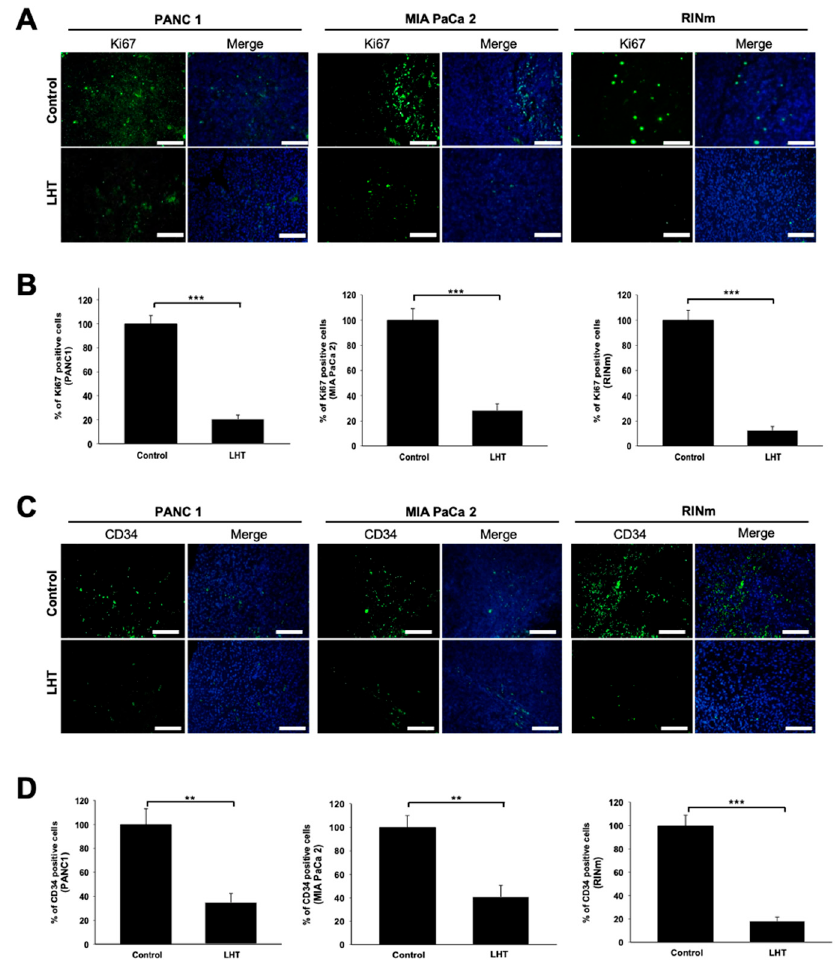
Figure 8. Inhibition of cell proliferation and angiogenesis in an orthotopic pancreatic tumor during intravenous administration of LHT. ( A ) Anti-Ki67 immunostaining of tumor tissues after intravenous administration of LHT (5 mg/kg/once every 2 days) or PBS (control) for 30 days. Blue: DAPI; Green: Anti-Ki67. Scale bars indicate 200 µm. ( B ) Relative quantification of anti-Ki67-positive cells in each group. Data were expressed with mean ± s.e.m. (n = 5). *** p < 0.001, compared to each control. ( C ) Anti-CD34 immunostaining of tumor tissues after intravenous administration of LHT (5 mg/kg/once every 2 days) or PBS (control) for 30 days. Blue: DAPI; Green: anti-CD34 microvessel. Scale bars indicate 200 µm. ( D ) Relative quantification of anti-CD34-positive cells. Data were expressed with mean ± s.e.m. (n = 5). ** p < 0.01, *** p < 0.001, compared to each control.